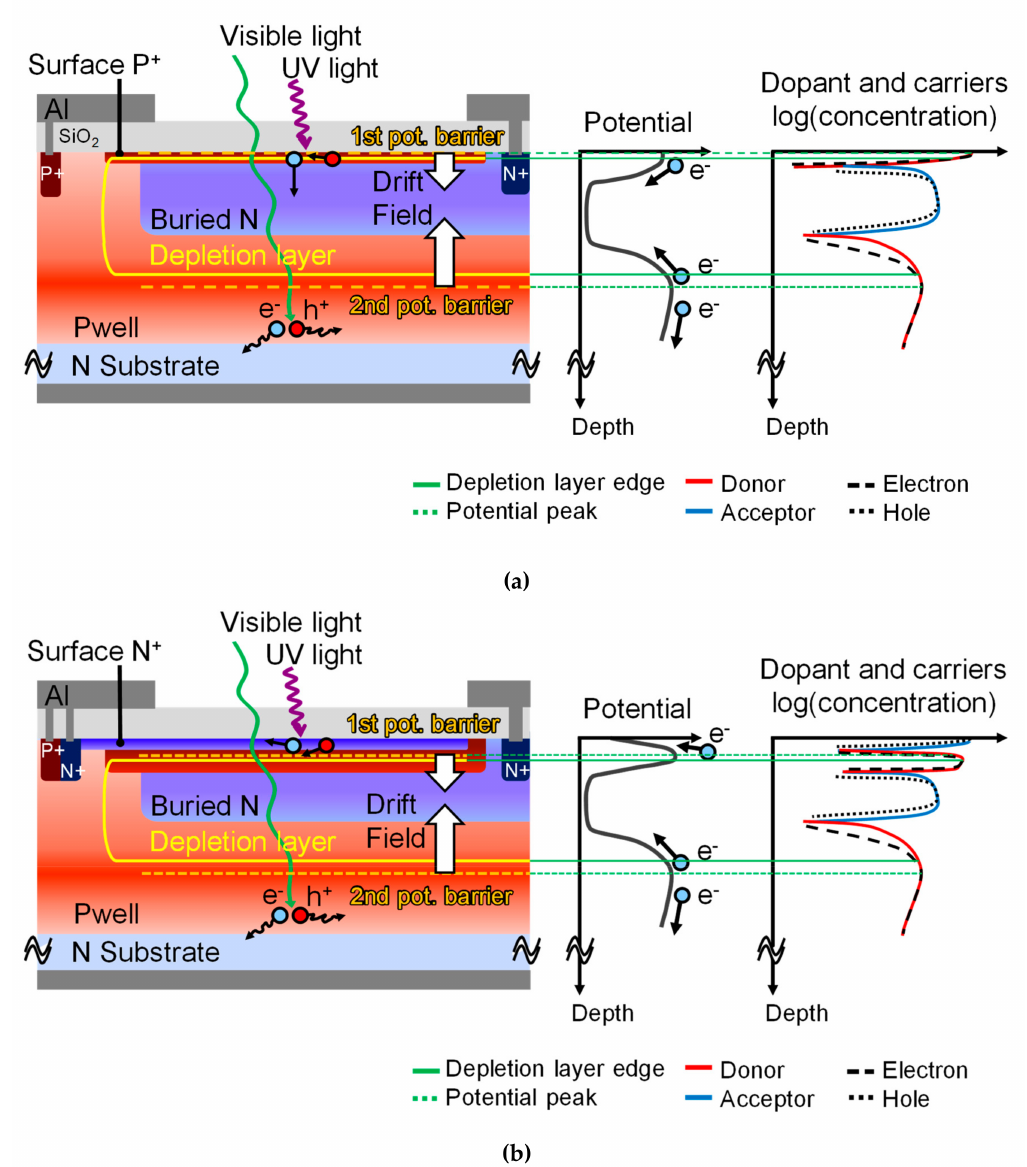
Figure 2. Device structures of the photodiodes (out of scale) ( a ) PD1, with high UV responsivity, and ( b ) PD2, with low UV responsivity. The potential maxima near the surface (first potential barrier) and within the Pwell layer (second potential barrier) are shown. The surface P + and surface N + layers are grounded and the buried N layer is biased at 0.3 V. Also, diagrams for the potential distribution and the concentrations of donors, acceptors, electrons and holes in the depth axis are presented for each type of